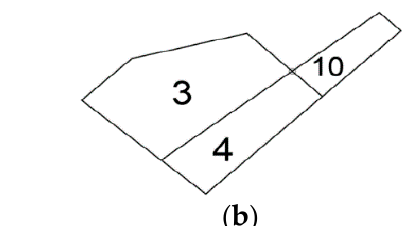
Figure 13. Case 1. ( a ) Undirected graph of three nodes; ( b ) merging graph of three sub-regions. In Figure 13b, the sub-region 3 corresponding to node 3 cannot be merged with the sub-region 10 corresponding to node 10.